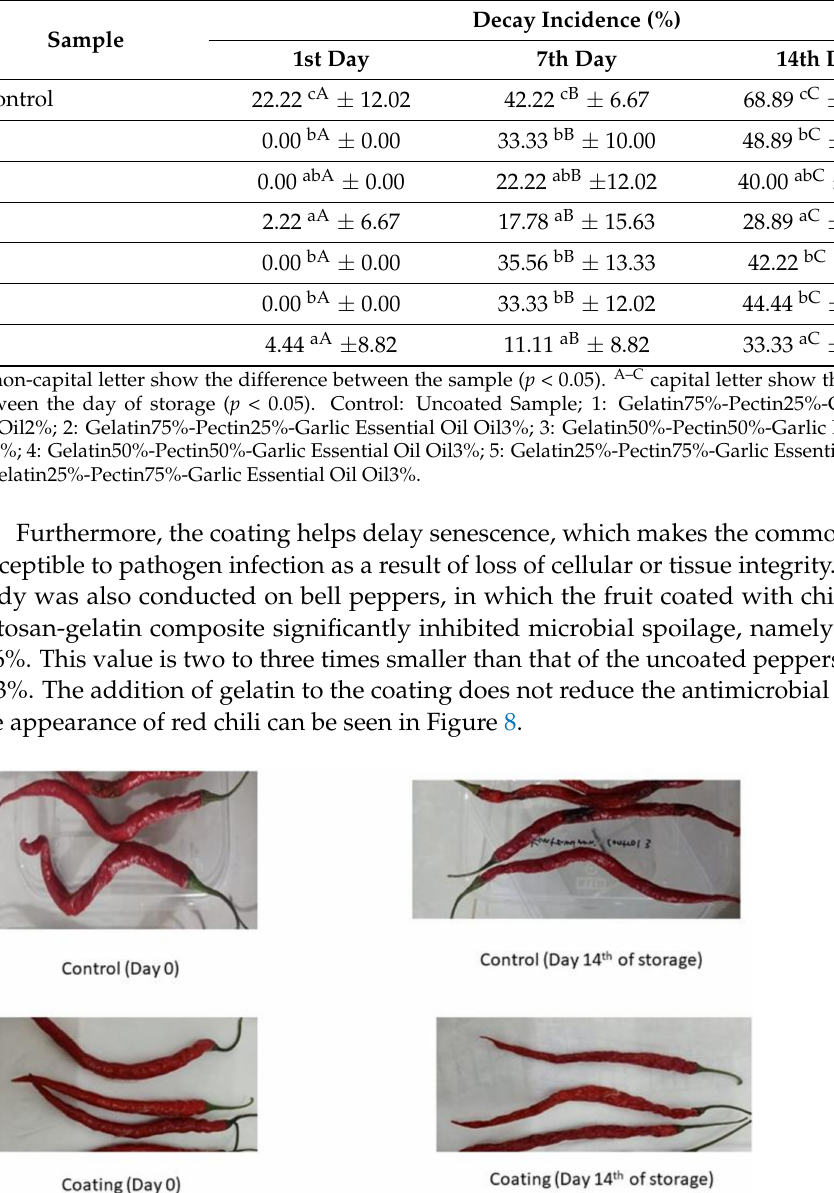
Table 2. Decay incidence of red chilli during storage.